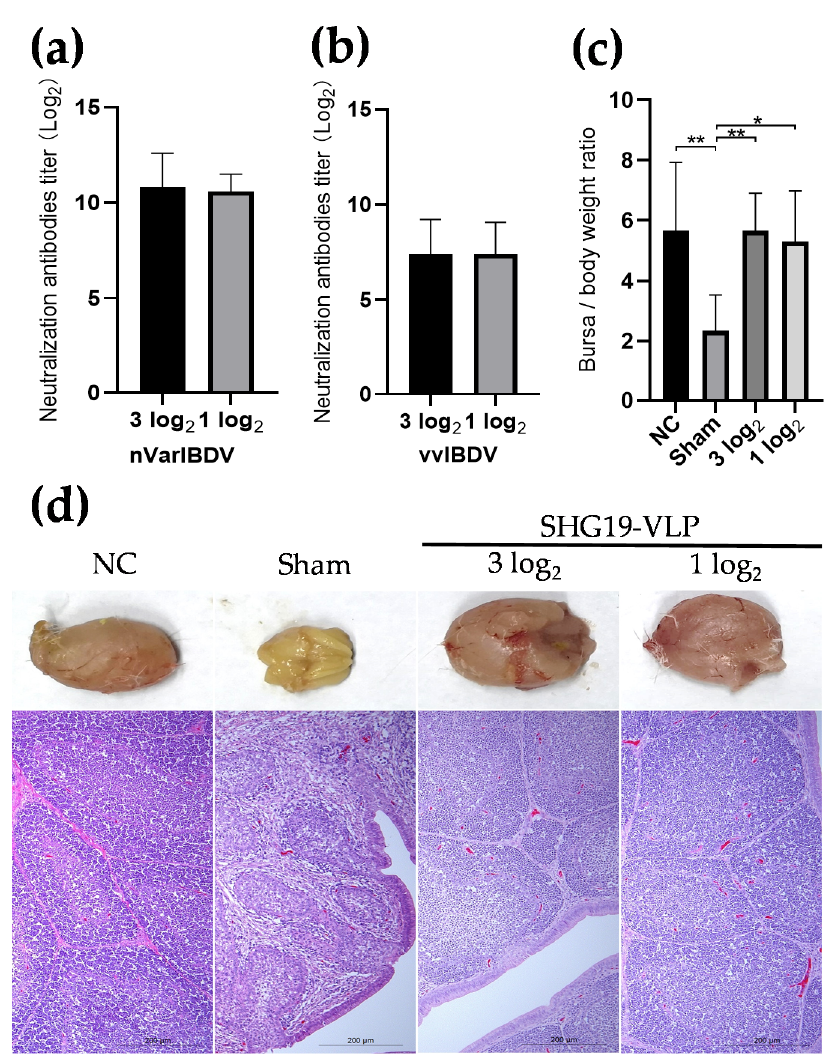
Figure 2. Evaluation of the immune effect of the SHG19-VLP vaccine against nVarIBDV. ( a ) Serum neutralization antibody titers against nVarIBDV antigen (rGtVarVP2) at 13 days post-vaccination; ( b ) Serum neutralization antibody titers against vvIBDV (rGtHLJVP2) at 13 days post-vaccination; ( c ) B/BW ratio at 7 days post-challenge. The average values and standard deviations (error bars) from different independent samples are shown; Asterisk signs were used to determine statistical significance among different groups (* p < 0.05; ** p < 0.01); ( d ) Gross appearance (upper side) and corresponding histopathological appearance (lower side) of the bursal sections (hematoxylin and eosin staining) at 7 days post-challenge.